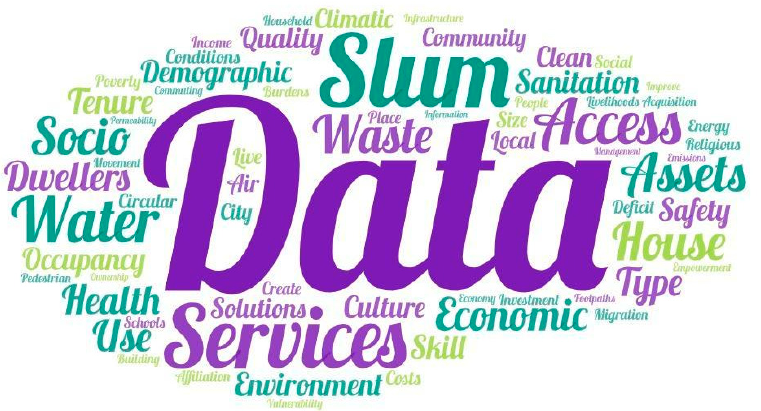
Figure 13. Word cloud of interaction with participants of WUF workshop (using Mentimeter) local data (characteristics) of deprived area information requirements by users.